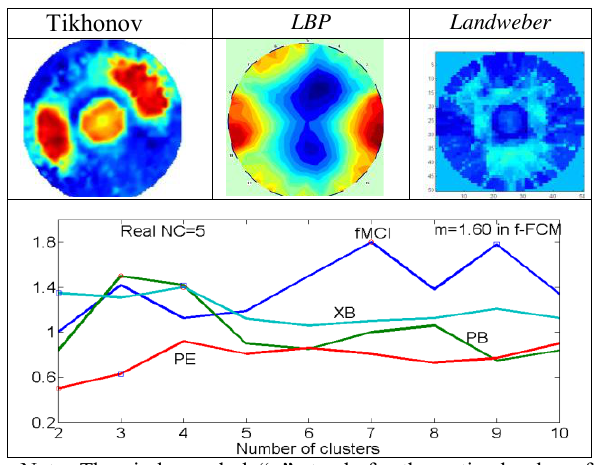
Table 2. Reconstructed images and their evaluations